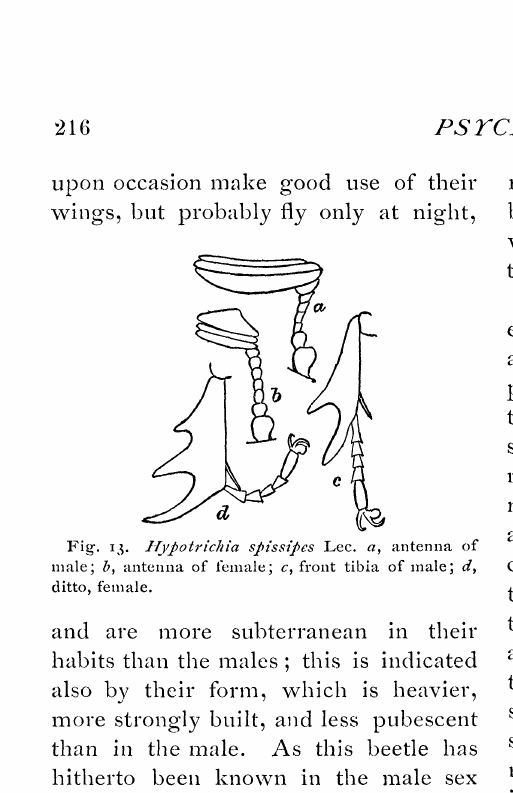
Fig. 3. t{l,2hotrichia siss@es Lec. a, antenna of male; b, antenna of female; c, front tibia of male; d, ditto,